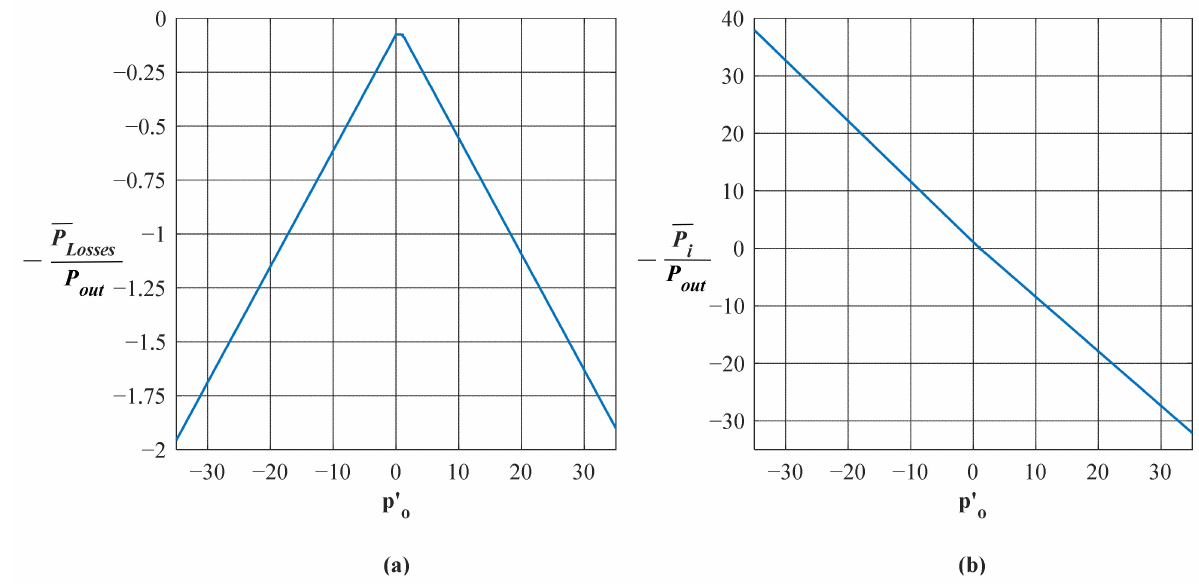
Figure 3. Results of Voltec analysis in FEV operation. ( a ) Mechanical power losses in the PSU as a fraction of − P out ; ( b ) MG I real power as a fraction of − P out